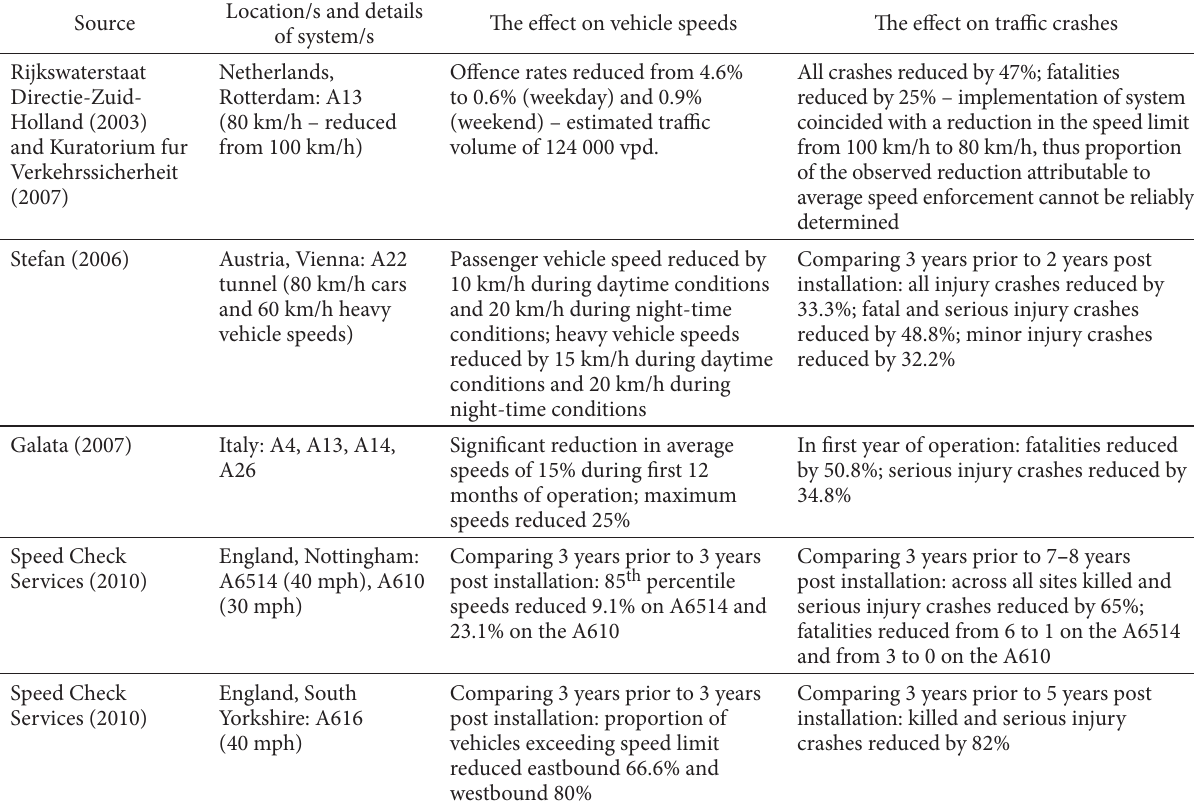
Table 1. Summary of findings related to the effect of average speed enforcement on vehicle speeds and road crashes Location/s and details The effect on vehicle speeds The effect on traffic crashes Source of system/s